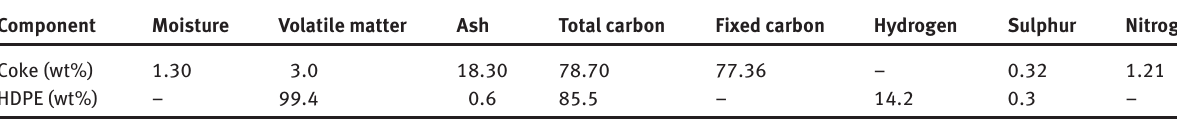
Table 2: Chemical analysis of carbonaceous materials used in this study Component